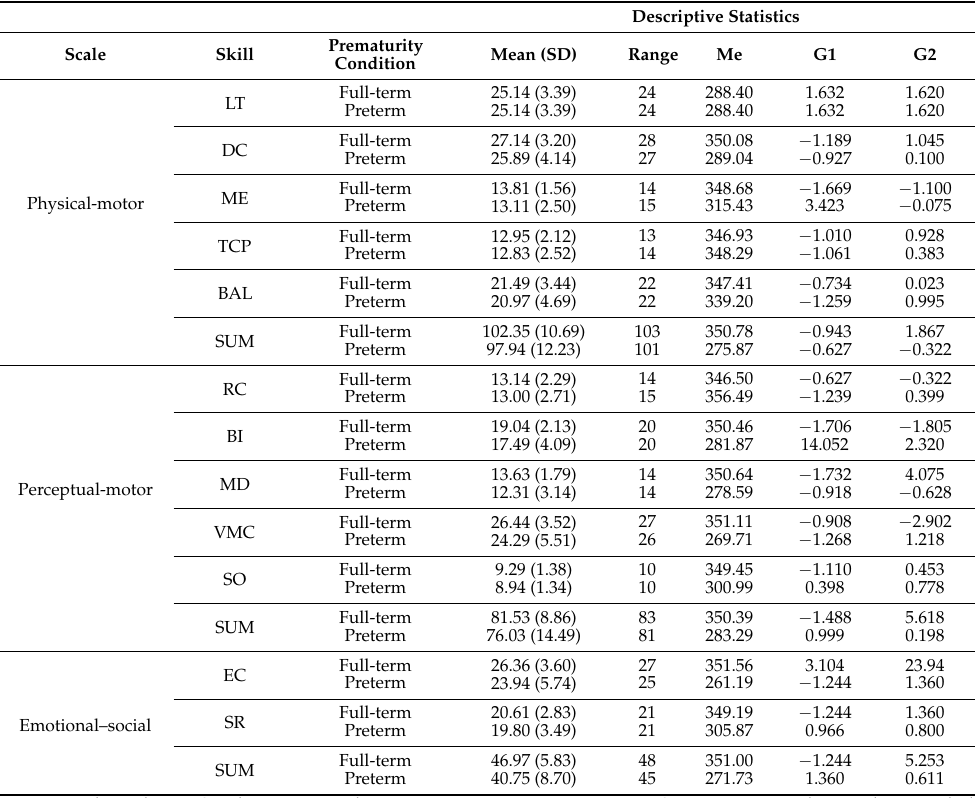
Table 3. Descriptive statistics for children born preterm and